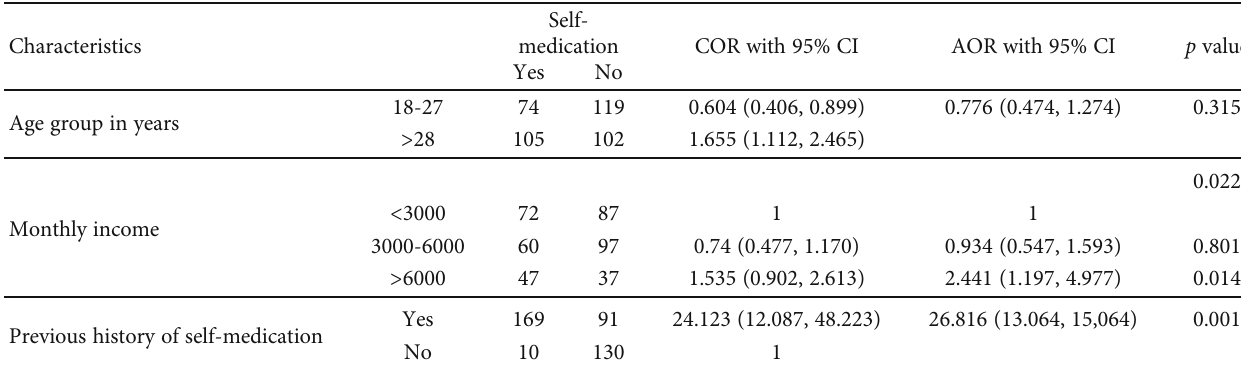
Table 6: Binary logistic regression analysis of factors associated with self-medication, self-medication with conventional medicine, and self- medication with herbal medicine among pregnant women at UoGCSH,